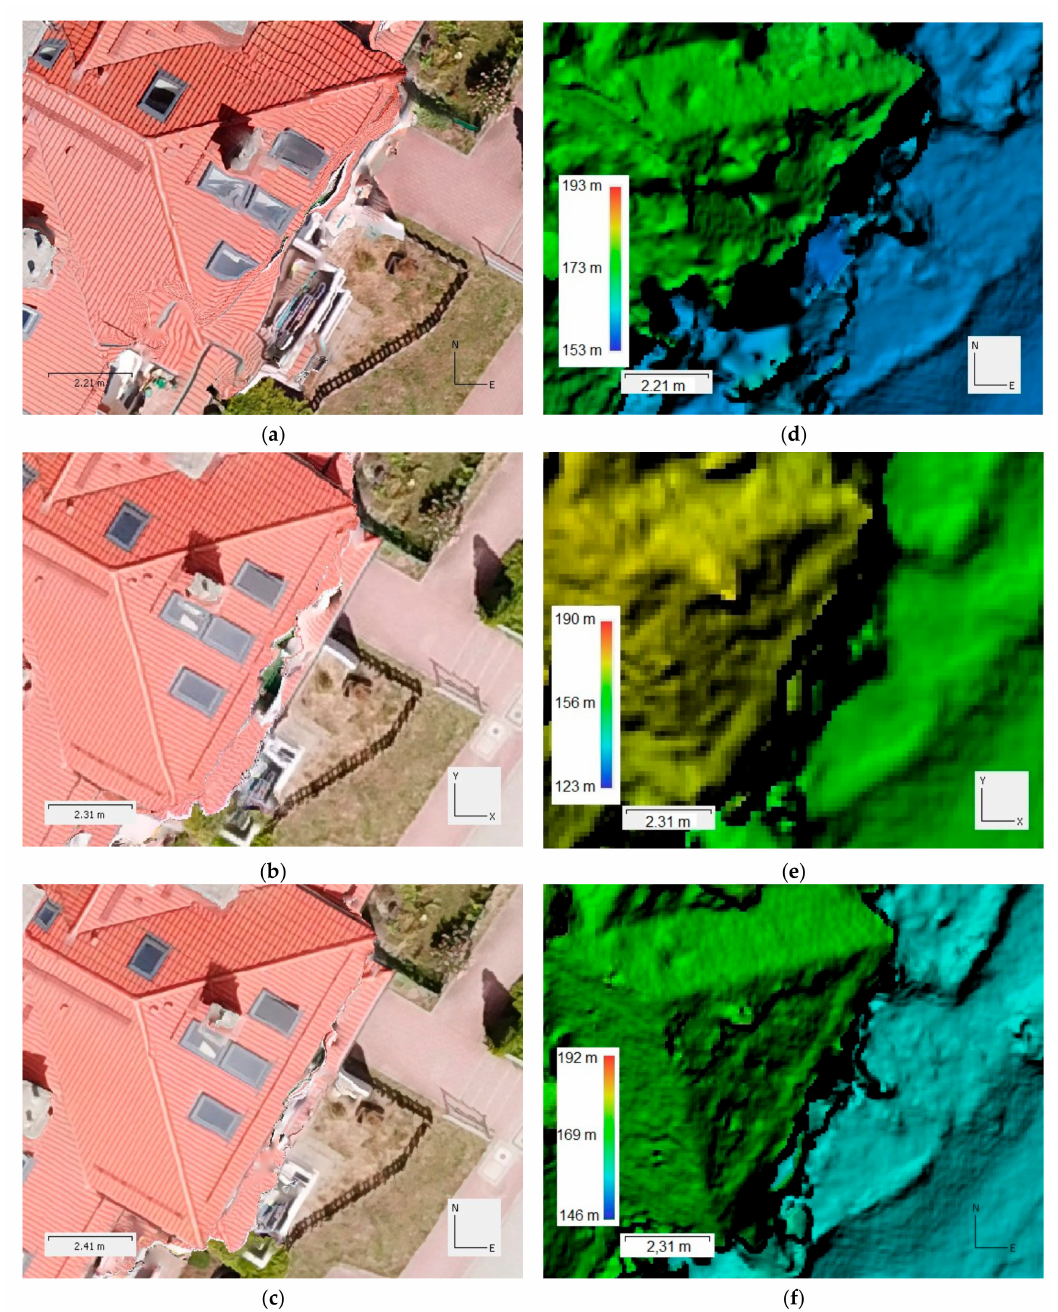
Figure 9. Results for the Mavic Pro orthophotomap at ( a ) 55 m, ( b ) 110 m, ( c ) SR and DEM at ( d ) 55 m, ( e ) 110 m, and ( f )